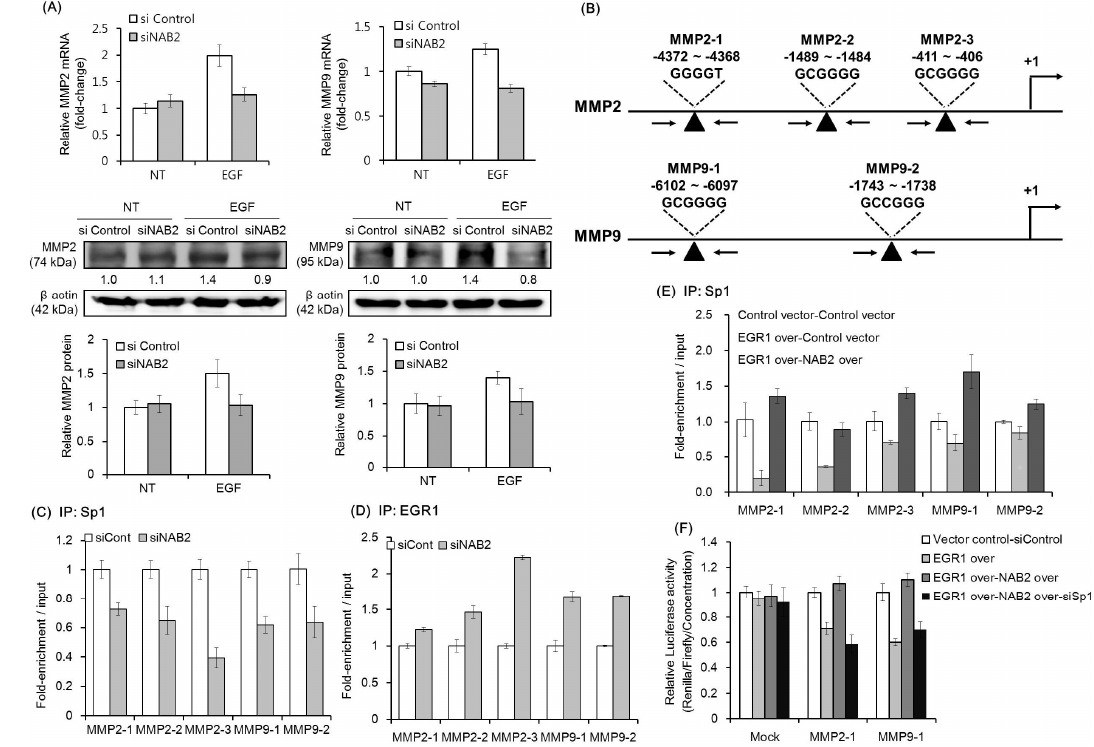
Figure 4. Effect of knockdown or overexpression of EGR1, NAB2, and Sp1 on MMP expression. ( A ) FaDU cells were transfected with control siRNA or siNAB2 for 24 h, and then subjected to EGF treatment (50 ng/mL) for another 24 h. Transfected cells were analyzed for mRNA and protein expression of MMP2 and MMP9. Protein expression was quantified and plotted in three independent experiments. ( B ) A schematic representation of the promoter regions containing the consensus EGR1/Sp1-binding sites (black arrowheads). FaDU cells were transfected with control siRNA or siNAB2 and chromatin was immunoprecipitated with ( C ) anti-Sp1 antibody or ( D ) anti-EGR1 antibody. The resulting immunoprecipitates were analyzed by qPCR to detect the consensus promoter sequences. ( E ) EGR1 / NAB2 genes were overexpressed in FaDU cells, after which chromatin was immunoprecipitated with an anti-Sp1 antibody. The resulting immunoprecipitates were analyzed by qPCR to detect the consensus promoter sequences. ( F ) For luciferase reporter assays using MMP2-1 and MMP9-1, promoter fragments were synthesized and cloned into the pGL4.70 vector. After 24 h of vector transfection, dual luciferase assays were performed to determine the effect of different combinations of EGR1/NBA2 overexpression (over) and/or Sp1 knockdown. The results shown are based on two or three independent experiments, with each bar representing the standard